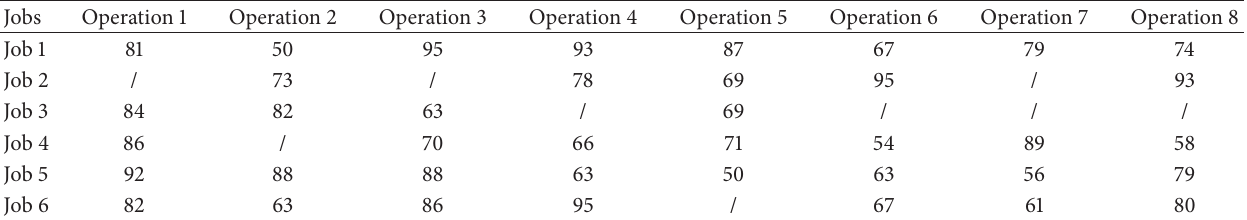
Table 3: The average time required for each operation of each job type before the training has been given to the worker.